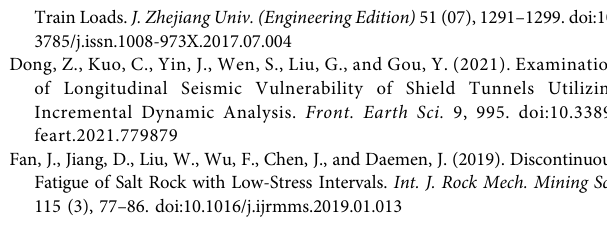
Frontiers in Earth Science |